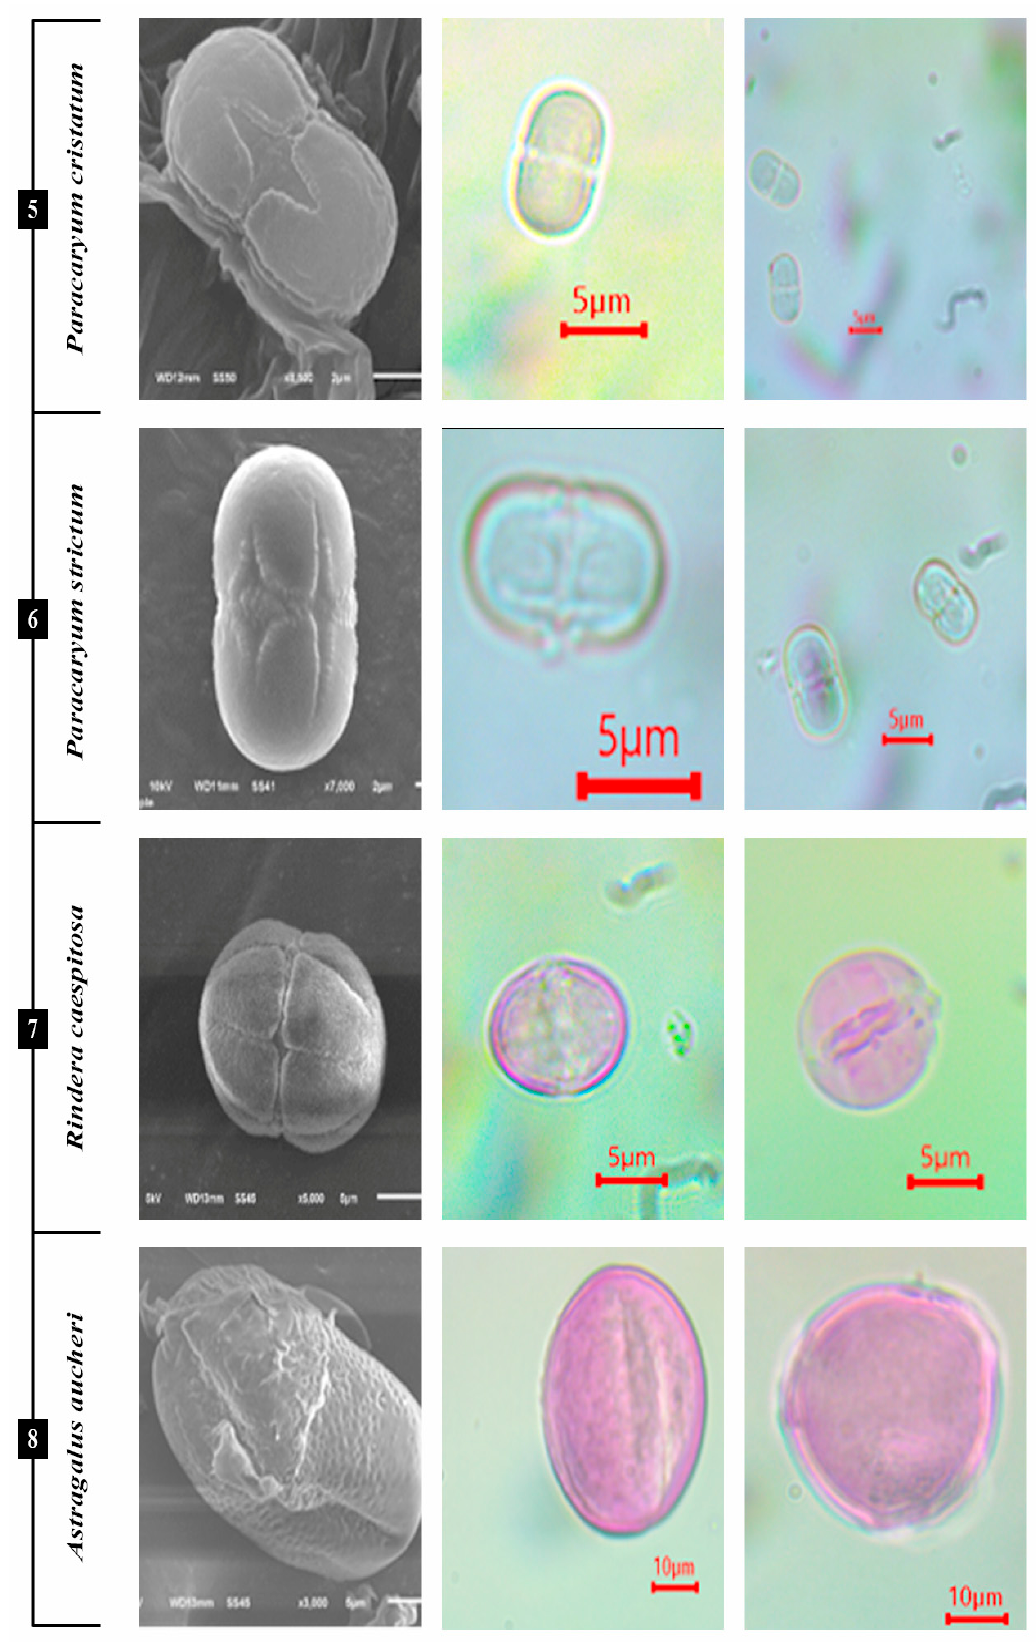
Figure 4. Scanning and light microscopic images of P. cristatum , P. strictum , R. caespitosa , and A. aucheri